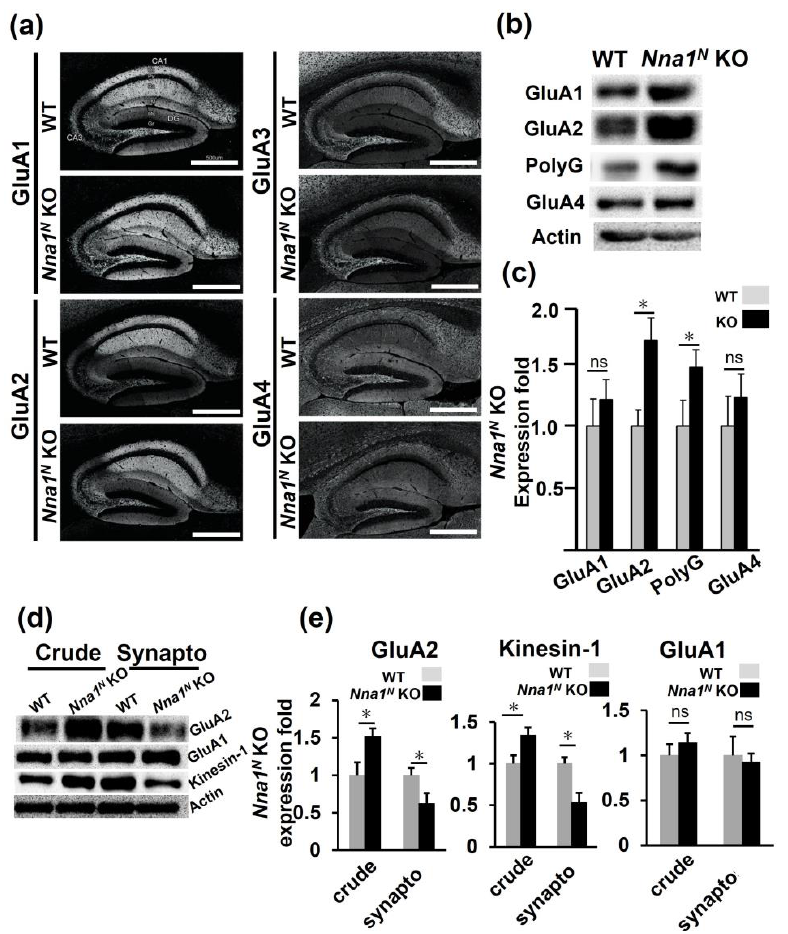
Figure 7. AMPA receptor expression in the hippocampus by immunohistochemistry and Western blotting analysis. ( a ) Protein expression of GluA1 – GluA4 in the hippocampus by immunohistochemistry. There was no significant difference between Nna1 N KO mice and WT ones in the expression of GluA1, GluA3, or GluA4 except for GluA2. Scale bars: 20 µM. ( b , c ) Crude fraction prepared from the hippocampus was loaded 20 ug each lane to investigate the expression of GluA1, GluA2, GluA4, and Polyglutamylated tubulin (PolyG). Note that increased expression of GluA2 and polyG was observed in the Nna1 N KO mice. All values presented are means ± SEM from 3 experiments. * p < 0.05, Student’s t -test. ( d , e ) kinesin-1 and GluA2 showed a similar expression pattern from the crude fraction (crude) to the synaptosome fraction (synapto). Note that significantly increased ex-